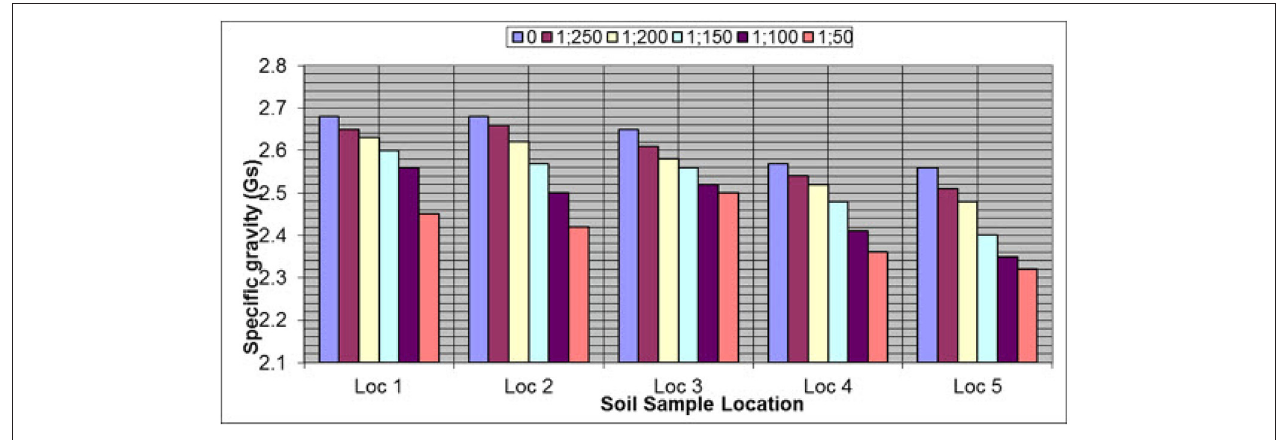
FIGURE 7 | Effect of addition of nano material on the specific gravity.